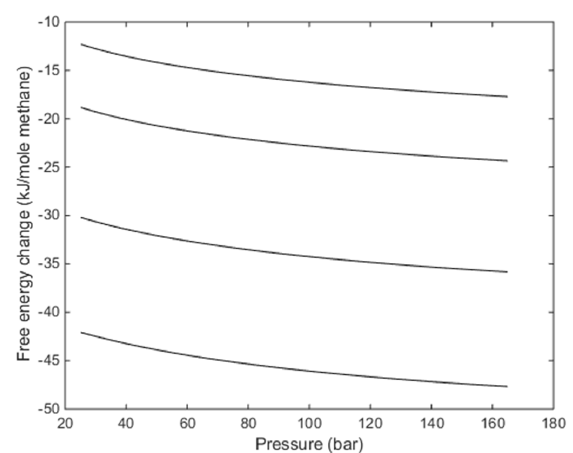
Table 3. Coefficients for free energy of N 2 inclusion in cavity type k. Figure 12. Free energy changes for hydrate dissociation by temperature increase. Top curve is for a temperature increase of 10 K, next is for a temperature increase of 25 K, then for a temperature increase of 50 K and lowest curve for 75 K. All pressures are pressures along the equilibrium curve in Figure 3 but for the same range as in Figure 10.